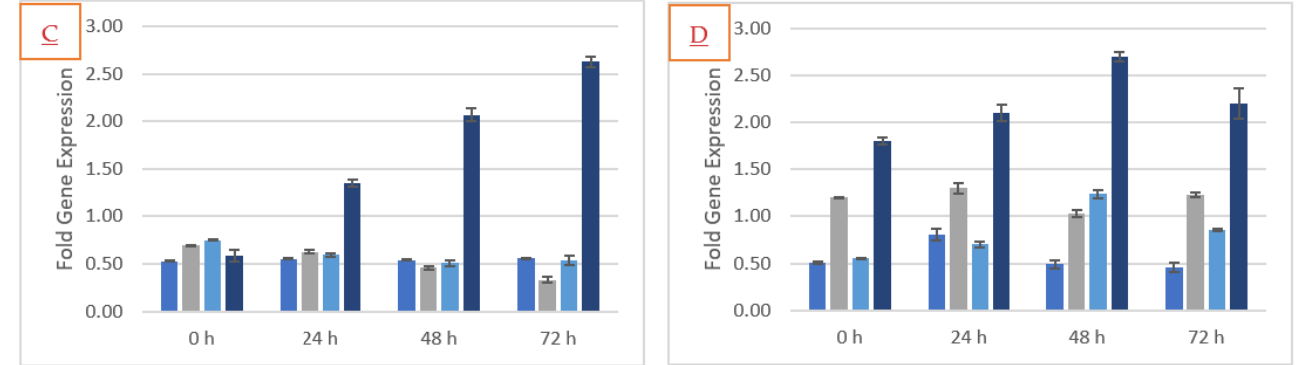
Figure 7. Defense gene expression of ( A ) WRKY, ( B ) TLP, ( C ) PR1 and ( D ) LOX during interaction of volatilomes of M. spicata immobilized vermiculite ball with F. oxysporum f. sp. lycopercisi inoculated Tomato Plant .